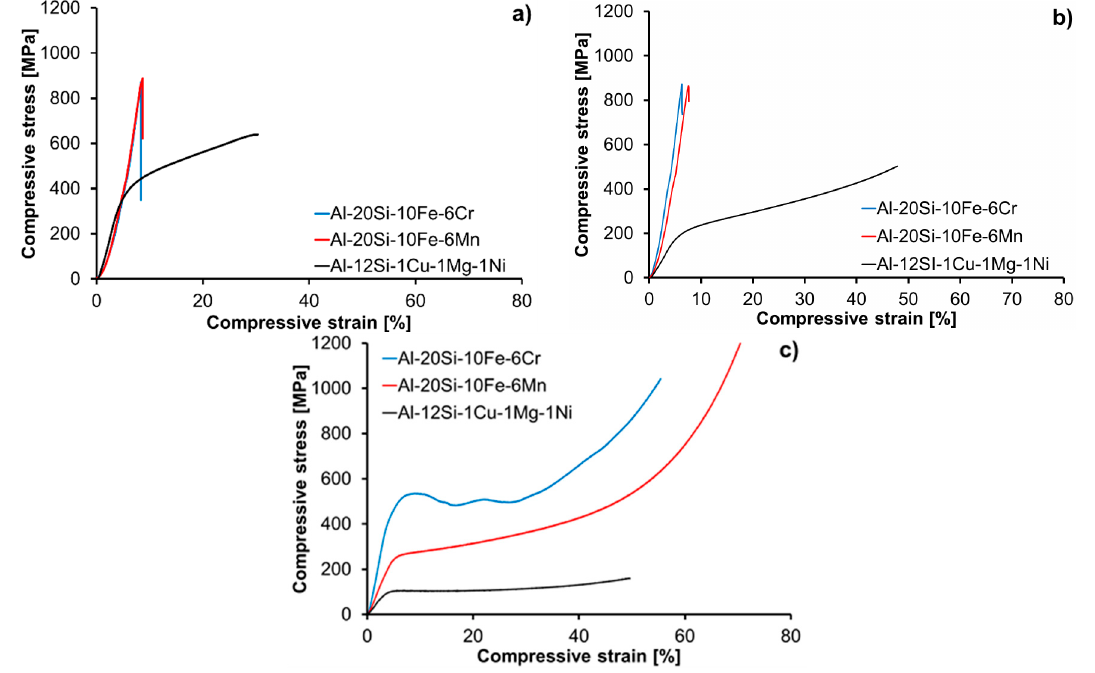
Figure 7. Compressive stress–strain curves of the MA + SPS alloys measured under different conditions: ( a ) laboratory temperature; ( b ) after 100 h of annealing at 400 °C; and ( c ) at 400 °C (10 min of tempering).